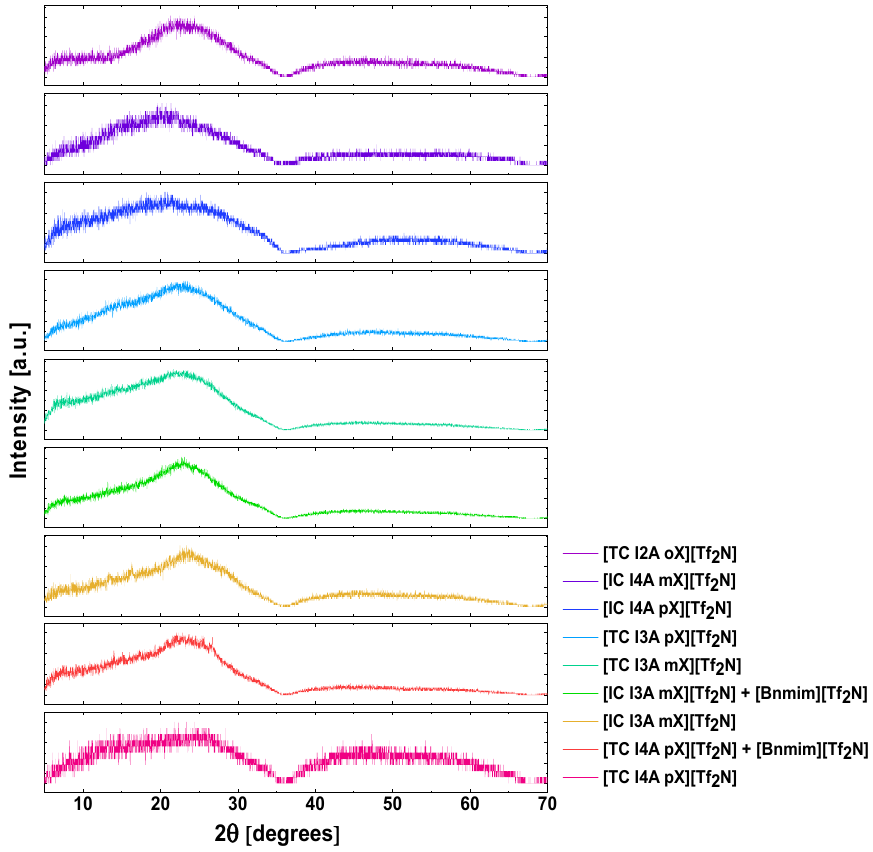
Figure 3. XRD profiles for all PA-ionene derivatives.